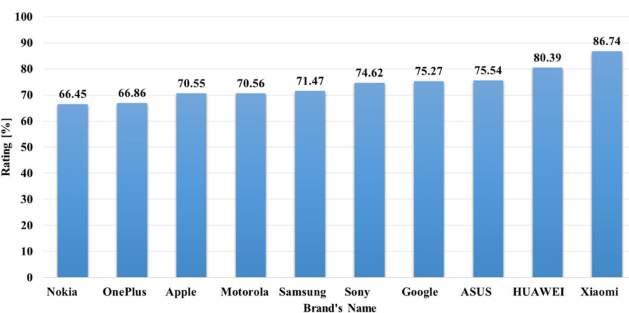
Figure 3. Rating analysis of the mobile phone brands.